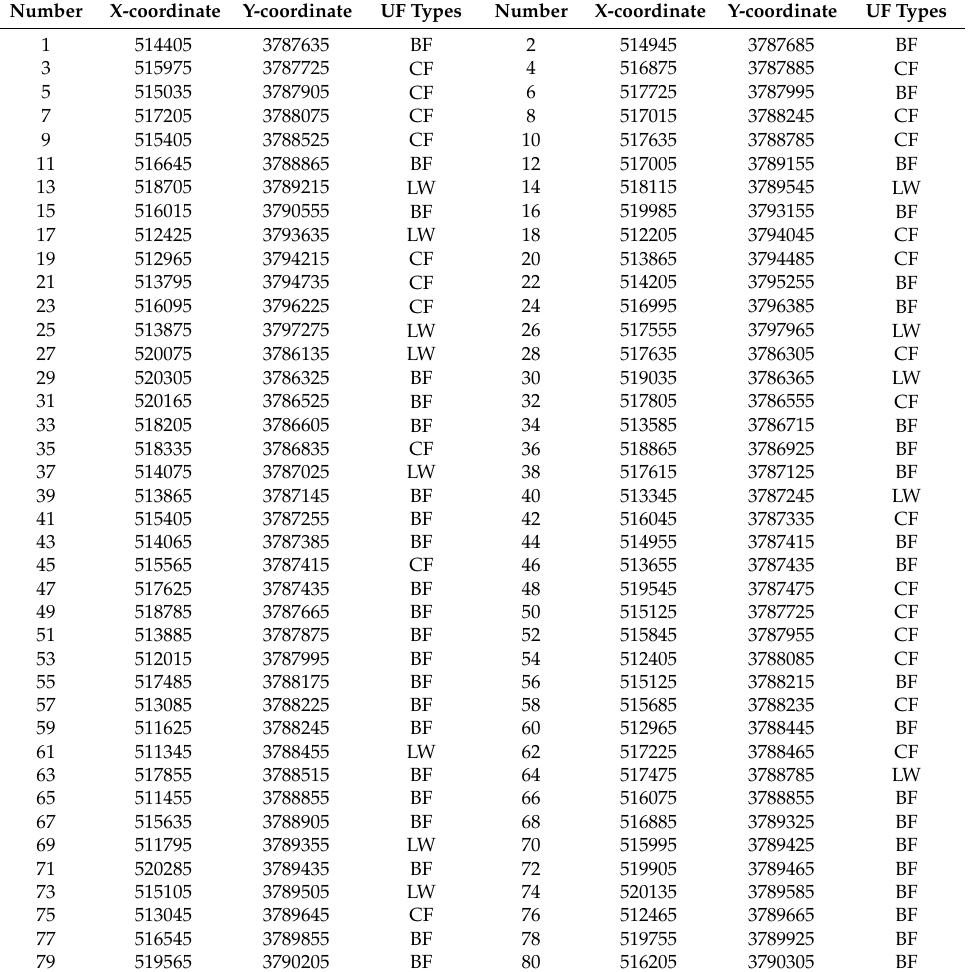
Table A1. Fieldwork sites for acquiring validation data for classification accuracy